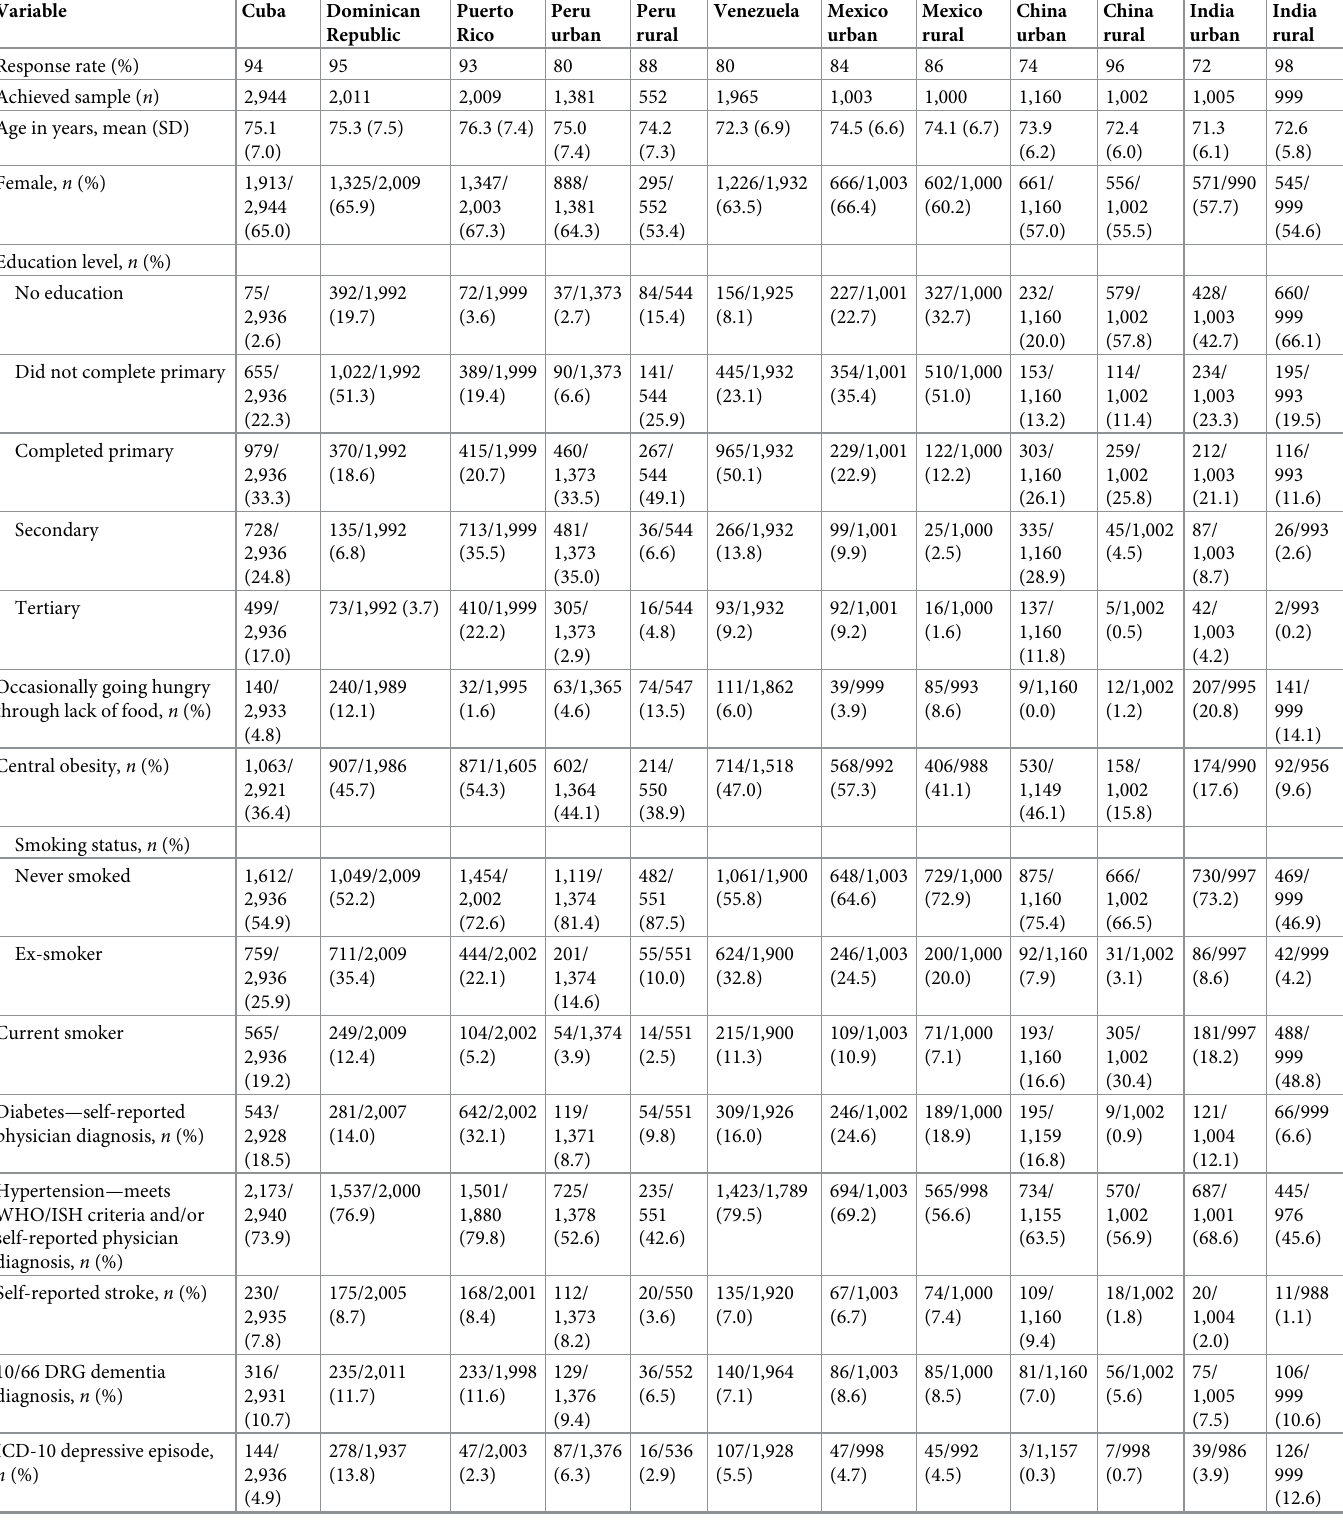
Table 1. Baseline sample: Participants’ sociodemographic, socioeconomic, and health characteristics, by site.